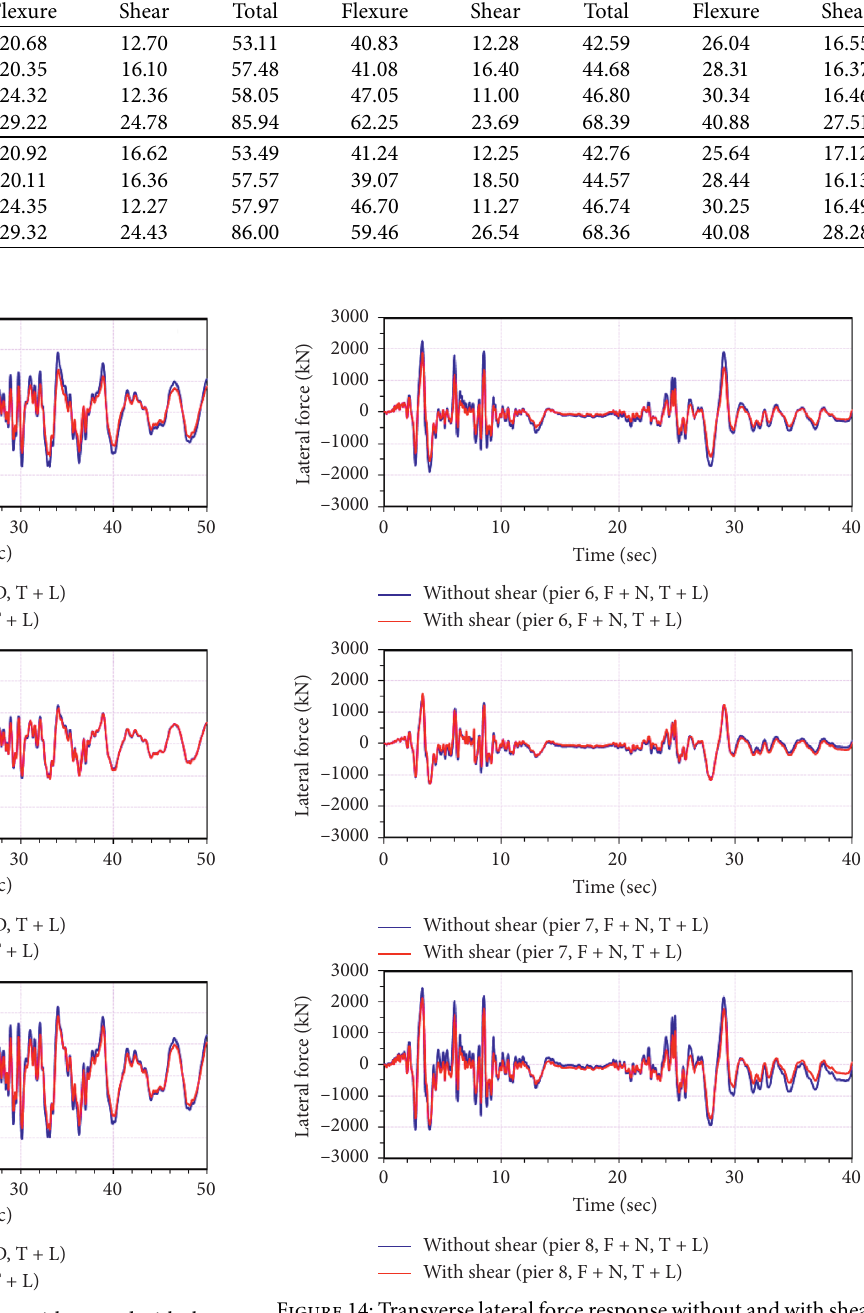
Figure 13: Transverse lateral force response without and with shear subjected to biaxial input ground motions of multiple earthquakes, K +D.